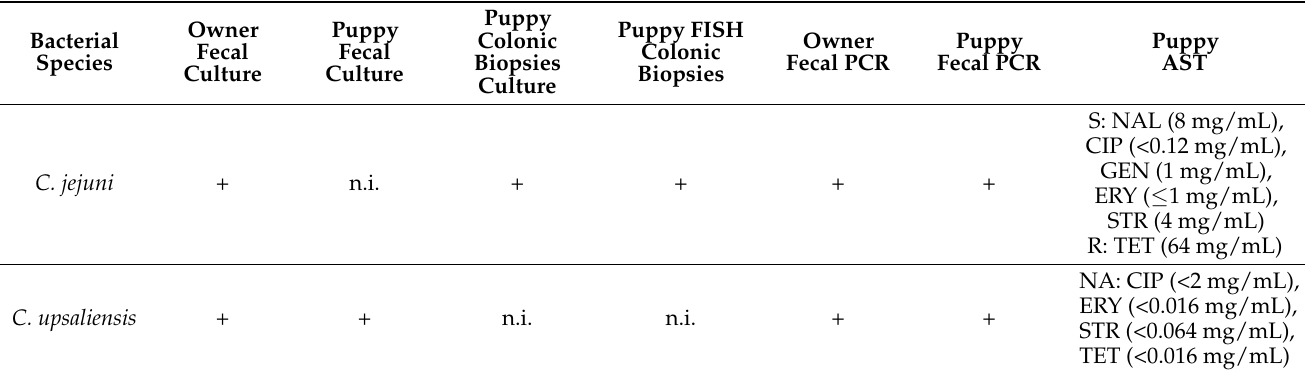
Table 5. Results of fecal cultures, PCR assays, FISH of both the puppy and the owner (where deemed), antibiotic susceptibility testing (AST).